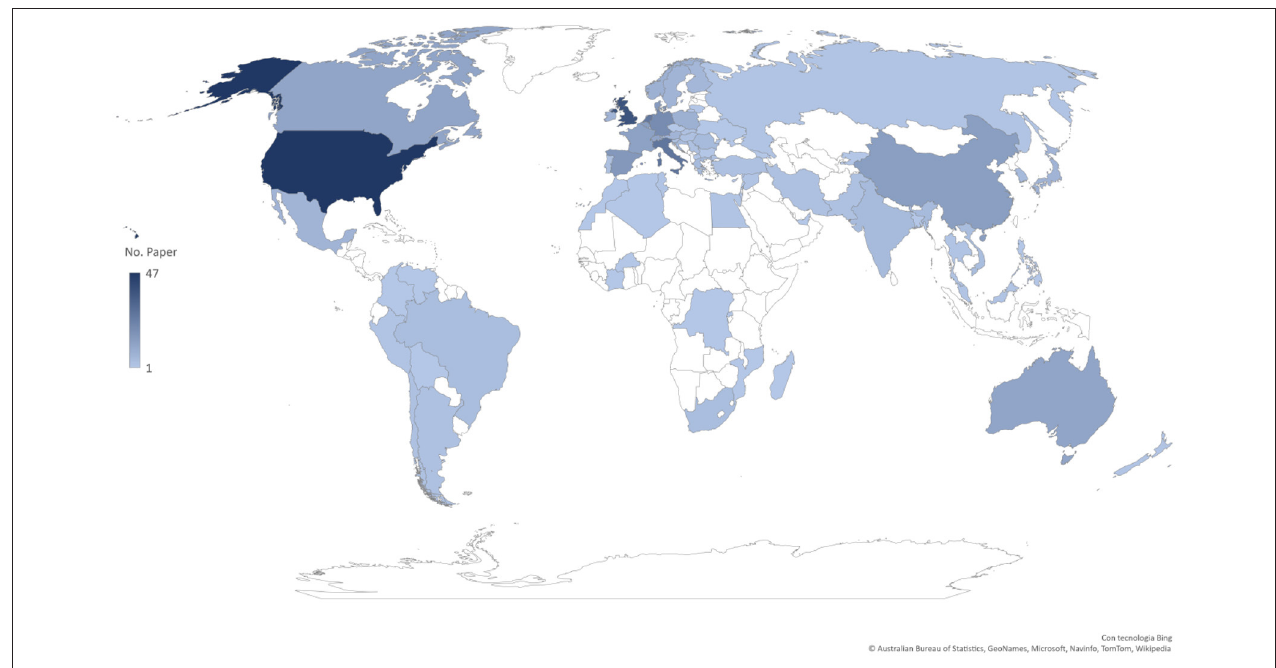
FIGURE 4 | Countries where the selected studies were conducted (Source: our elaboration).